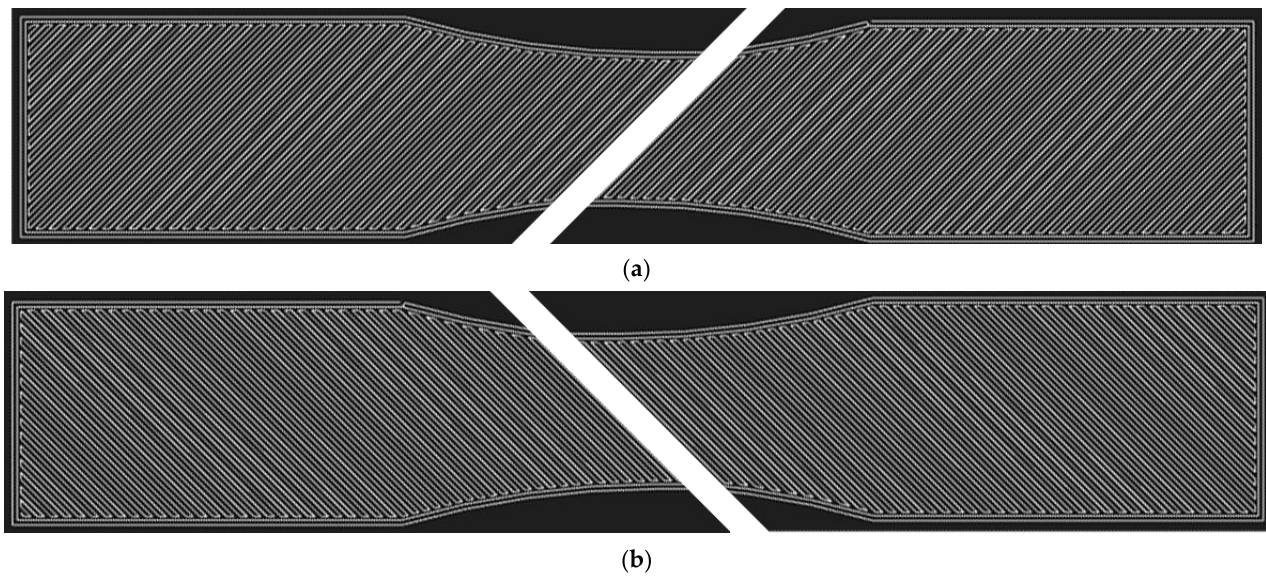
Figure 6. Infill orientation to loading axis: ( a ) 45° angle; ( b ) − 45° angle. The layers are stacked alternately. The white lines represent the defined path of material deposition.